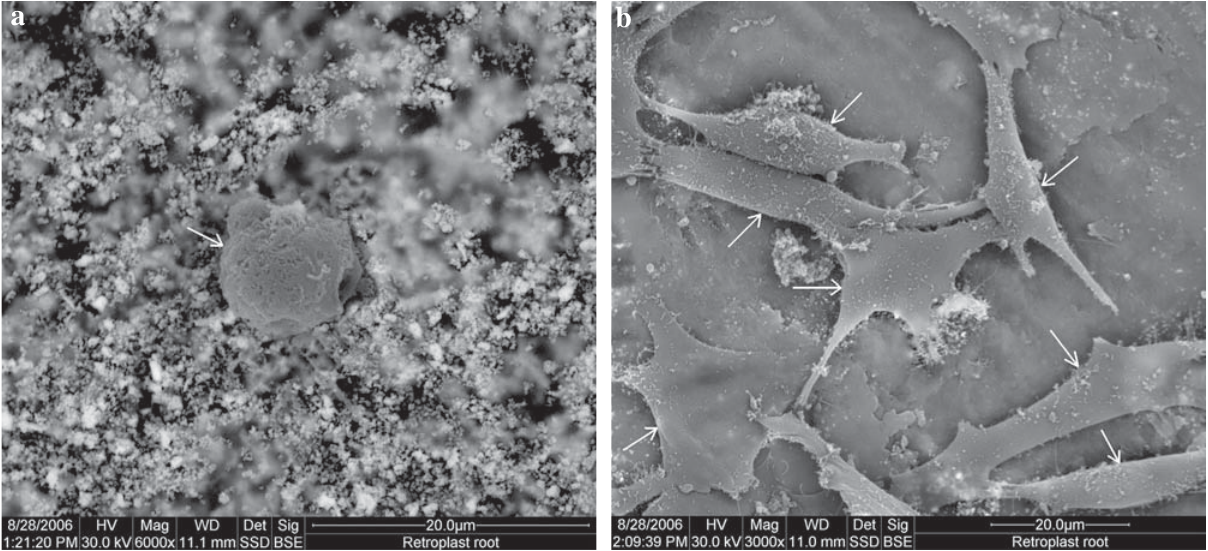
Figure 8 (cid:7)(cid:12)(cid:31)(cid:21)(cid:15)(cid:6)(cid:6)(cid:5)(cid:6)(cid:13)(cid:12)(cid:3)(cid:14)(cid:3)(cid:21)(cid:17)(cid:16)(cid:9)(cid:6)(cid:12)(cid:8)(cid:5)(cid:21)(cid:16)(cid:9)(cid:4)(cid:21)(cid:9)(cid:22)(cid:3)(cid:12)(cid:24)(cid:31)!"(cid:29)(cid:12)(cid:8)(cid:5)(cid:21)(cid:16)(cid:9)(cid:13)(cid:16)(cid:15)(cid:22)(cid:18)(cid:12)(cid:9)(cid:23)(cid:12)(cid:2)(cid:3)(cid:17)(cid:16)(cid:9)(cid:22)(cid:14)(cid:15)(cid:4)(cid:17)%(cid:12)(cid:24)(cid:15)(cid:29)(cid:12)(cid:8)(cid:15)(cid:17)(cid:3)(cid:16)(cid:5)(cid:15)(cid:14)(cid:12)(cid:4)(cid:19)(cid:16)(cid:23)(cid:15)(cid:21)(cid:3)(cid:12)(cid:24)(cid:9)(cid:16)(cid:5)(cid:13)(cid:5)(cid:6)(cid:15)(cid:14)(cid:12)(cid:8)(cid:15)(cid:13)(cid:6)(cid:5)(cid:11)(cid:21)(cid:15)(cid:17)(cid:5)(cid:9)(cid:6)(cid:12)